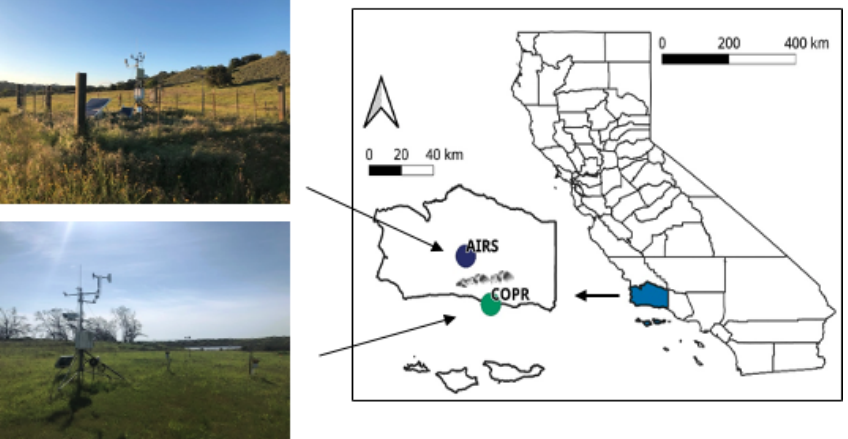
Figure 1. Location of stations in Santa Barbara County showing the coastal grassland site (COPR, green), with a marine microclimate, and the semiarid inland grassland site (AIRS, blue) north of the Santa Ynez mountain